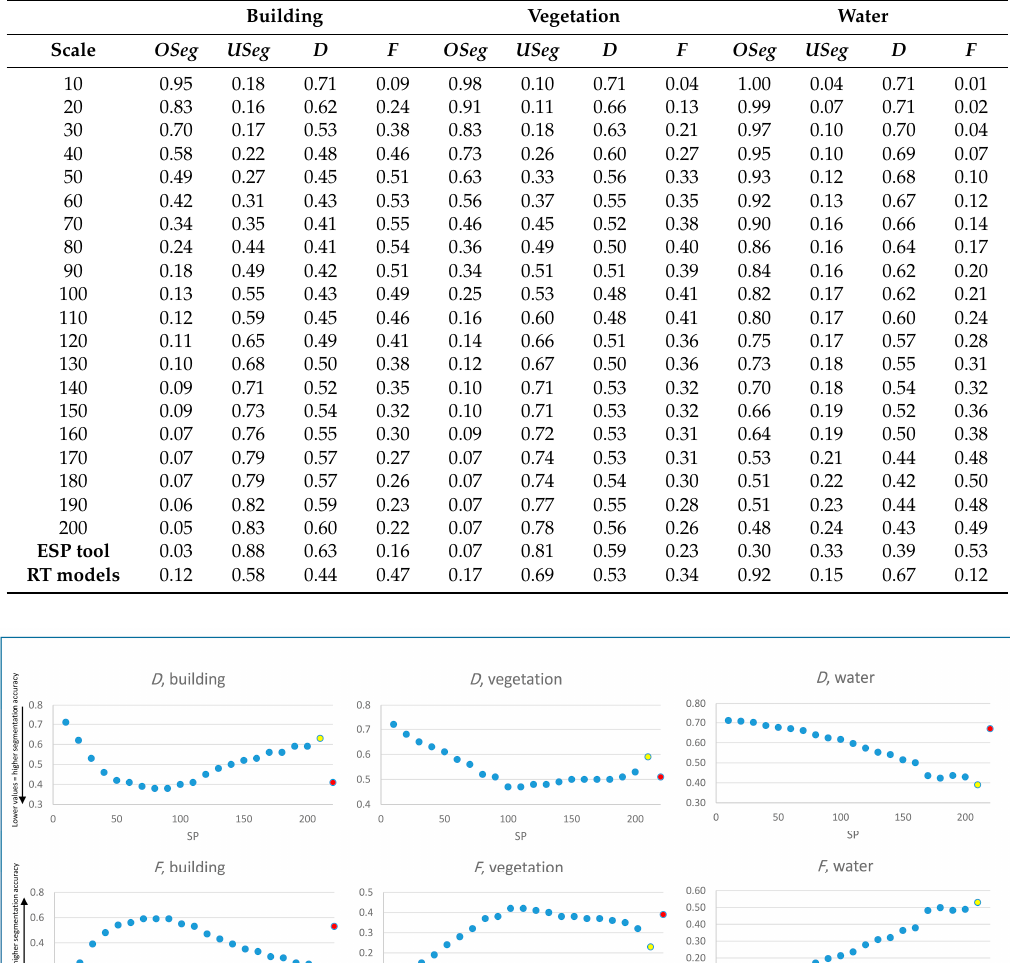
Table 6. Values of the supervised metrics calculated using all of the reference polygons for each class. The SP values used for the RT model varied by land cover class and image, and are provided in Table 3. The SP values selected by the ESP tool were: 161 (25-cm image), 236 (30-cm image), 251 (50-cm image), 266 (65-cm image), 291 (75-cm image), 271 (1-m image). Note: The parameters used for the segmentation of the test images are given in Tables 4 and 5.